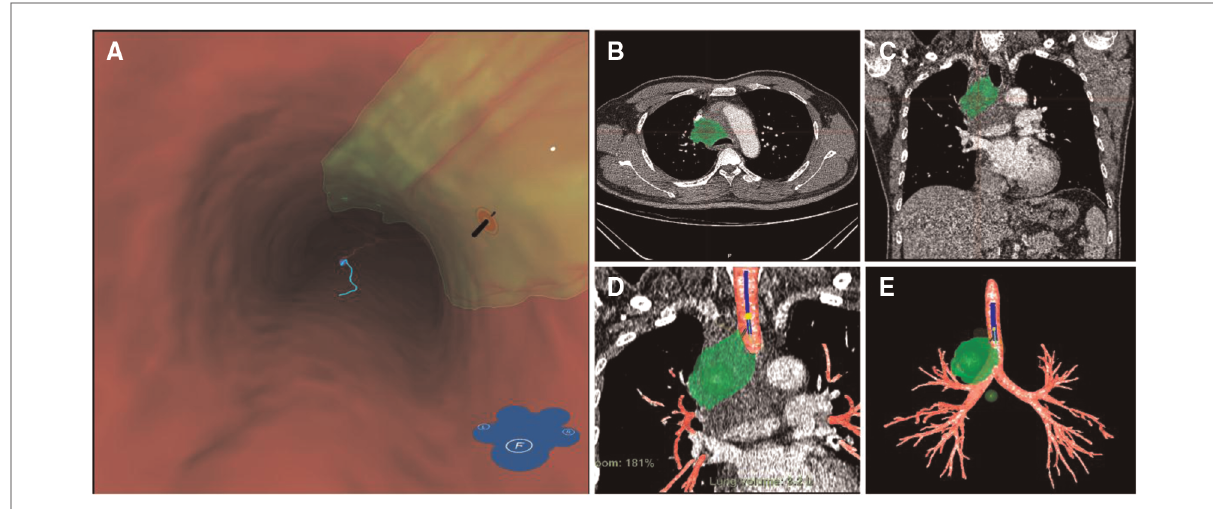
FIGURE 2 Three-dimensional anatomical structures were reconstructed using a VBN system (archimedes virtual bronchoscopy navigation system). ( A ) Intraluminal view and puncture sight (green). ( B ) Axial view of the location of the mediastinal lesion (green dot). ( C ) Coronal view of the location of the mediastinal lesion (green dot). ( D ) VBN image showed the target lesion (green dot) and the route for TBNA (light blue line). ( E ) the anatomical structure of the mediastinal mass and bronchial tree.